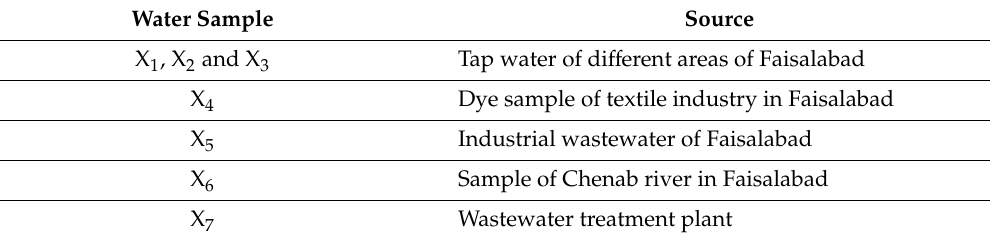
Table 1. Labeling of water samples collected from different sites in Faisalabad.